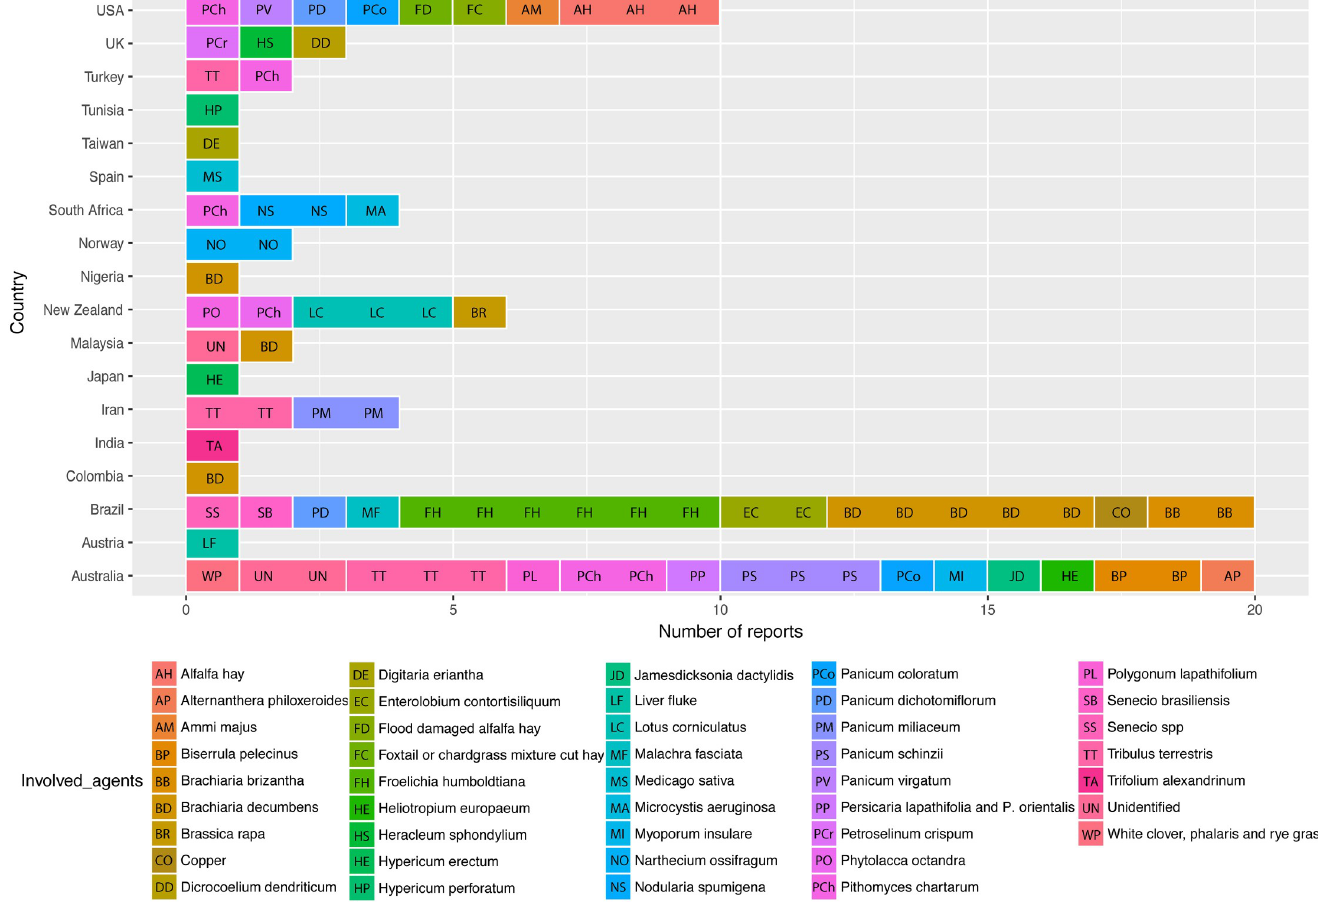
Fig 5. Causative agents identified in peer-reviewed photosensitisation case reports